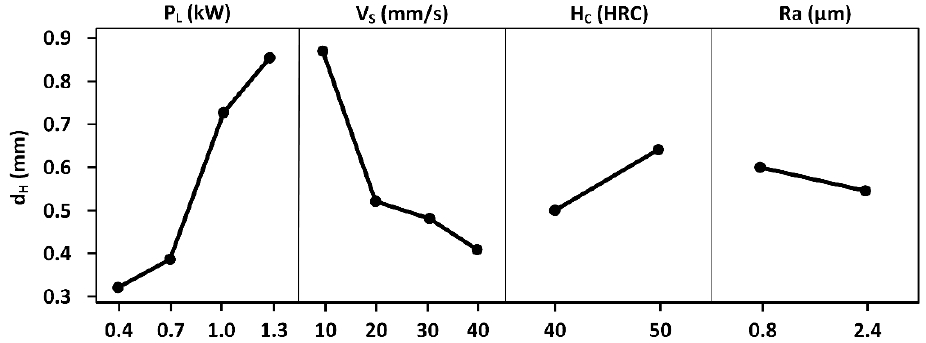
Figure 2. Representation of LHQ elements through the hardness profile curve.